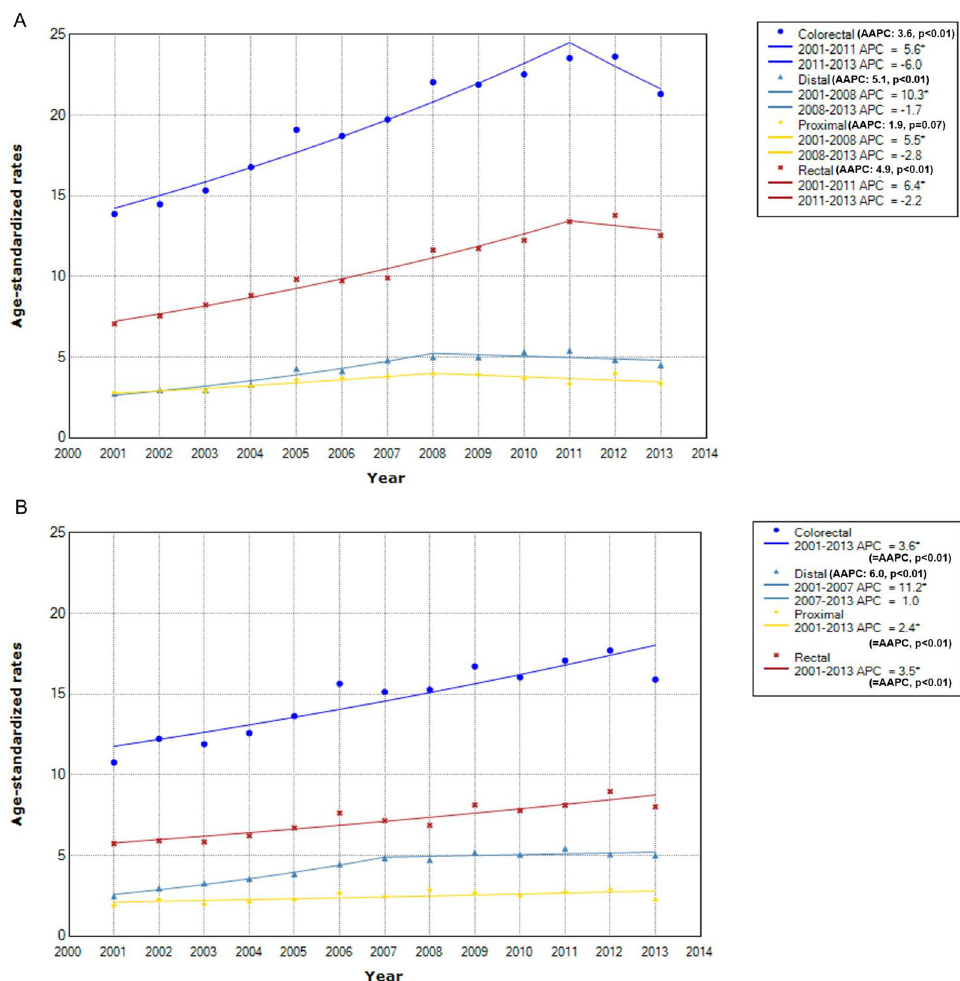
Figure 2. Time trend of early-onset colorectal cancer incidence rates by sex and anatomical subsite. * Indicates that APC is significantly different from zero at the alpha = 0.05 level. ( A ) In men. ( B ) In